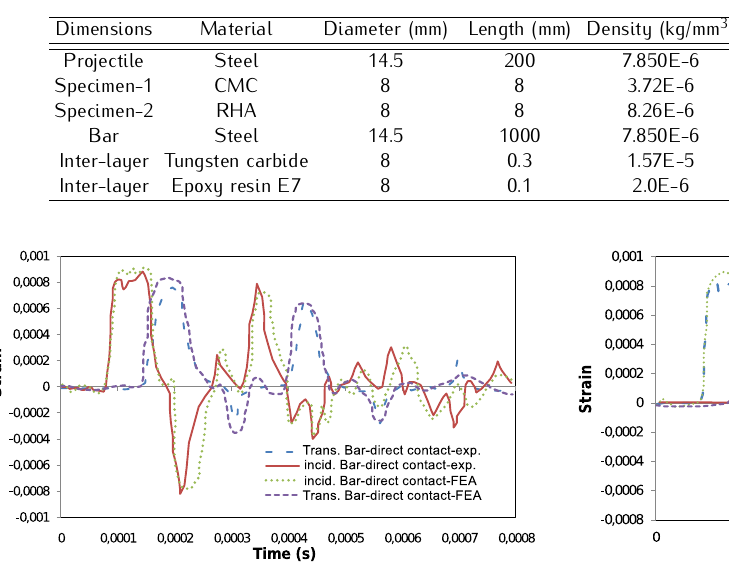
Table 2. Dimensions and mechanical properties used for the FEA model in case study.